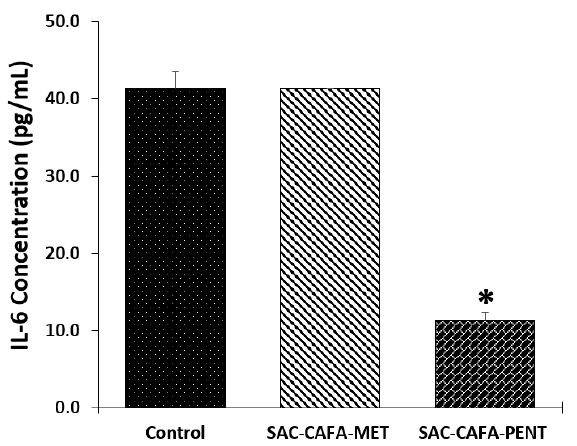
Figure 5. Levels of the pro-inflammatory cytokine IL-6 in SW480 cells 48 h post-treatment with the hybrids SAC-CAFA-MET (124.2 µM) and SAC-CAFA-PENT (118 µM) or 1% DMSO (control). Data are presented as the mean ± SE of three independent experiments (* p < 0.05).